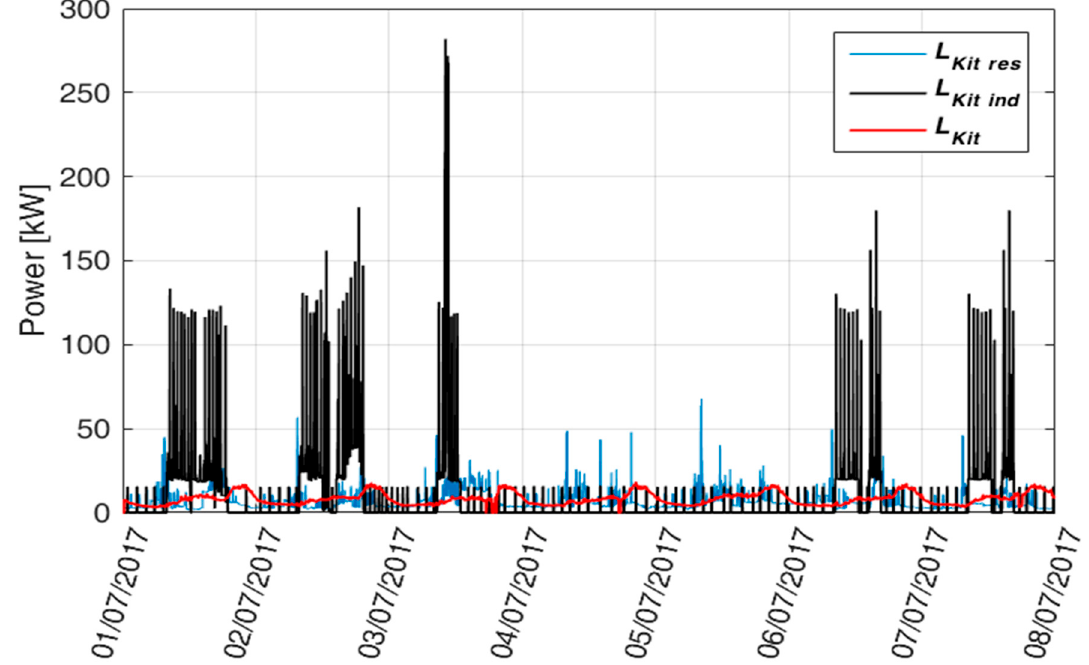
Figure 1. (𝑳 𝑲𝒊𝒕 , 𝑳 𝑲𝒊𝒕 time